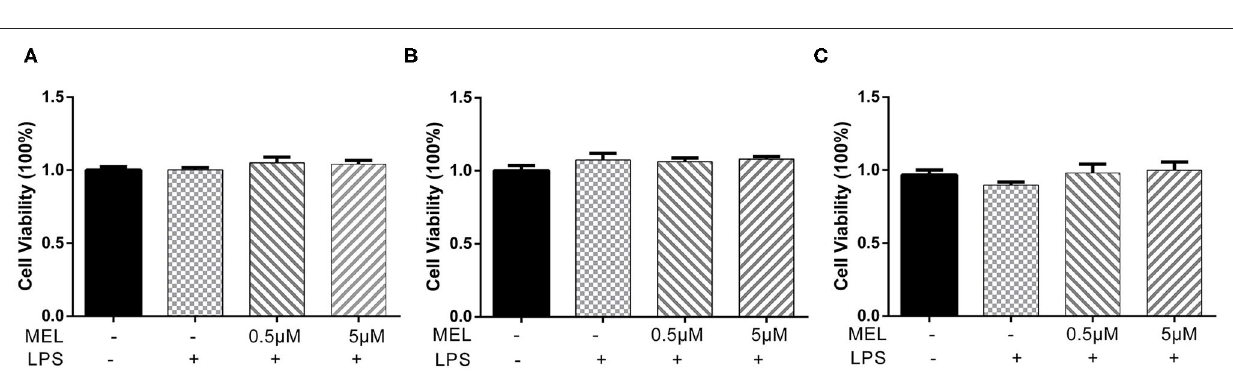
FIGURE 2 | The effect of meloxicam on the viability of primary bovine endometrial epithelial cells. MEL, meloxicam. The cells were treated with MEL (5 × 10 − 2 , 5 × 10 − 1 , 5, and 50 µ M) alone for 24h. The cell viability was detected using the Cell Counting Kit-8 method. All data were presented as means ± SEM ( n = 3).